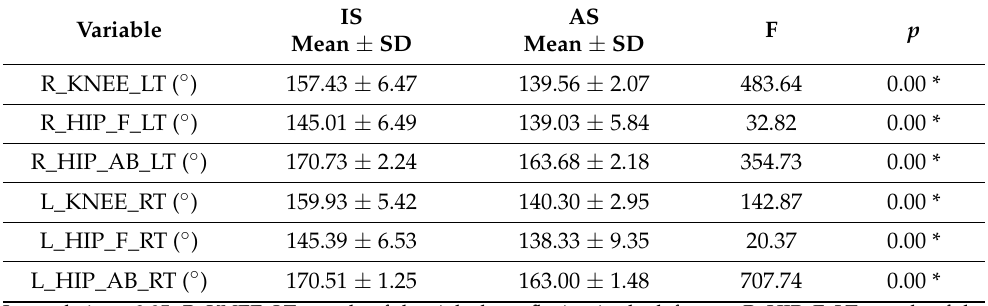
Table 2. Basic descriptive statistical parameters and MANOVA of kinematic parameters for IS and AS.